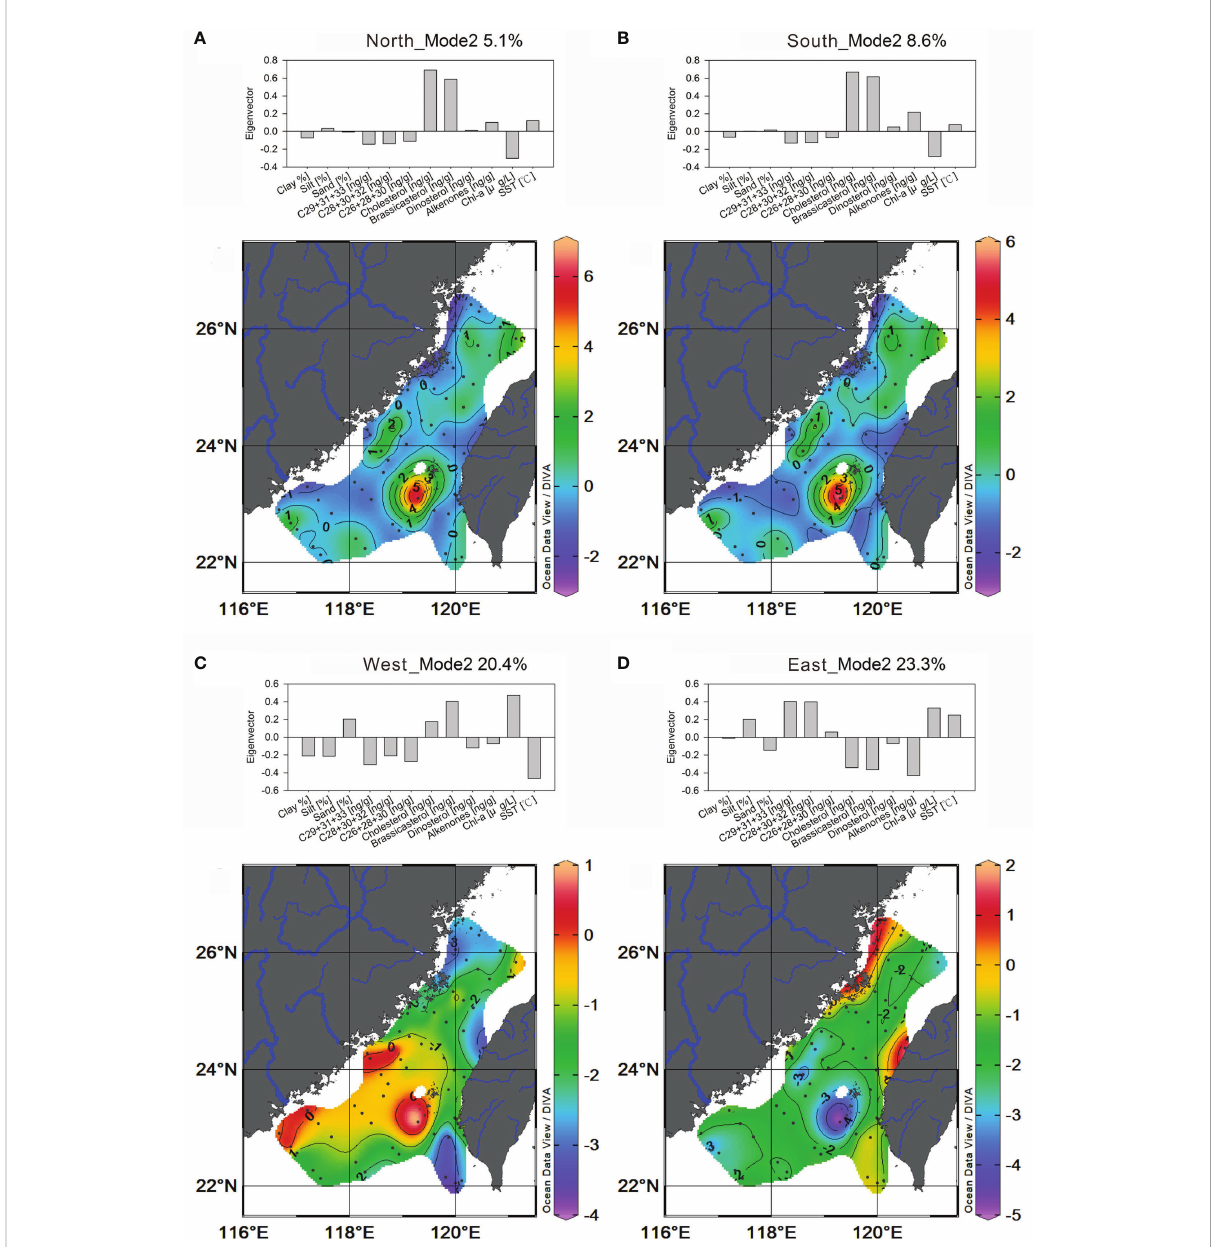
FIGURE 7 Plots of mode 2 eigenvectors (histograms) and contoured eigenweightings of the deviation fi eld for hypothetical sources from the north (A) ; the south (B) ; west (C) ; and east (D)